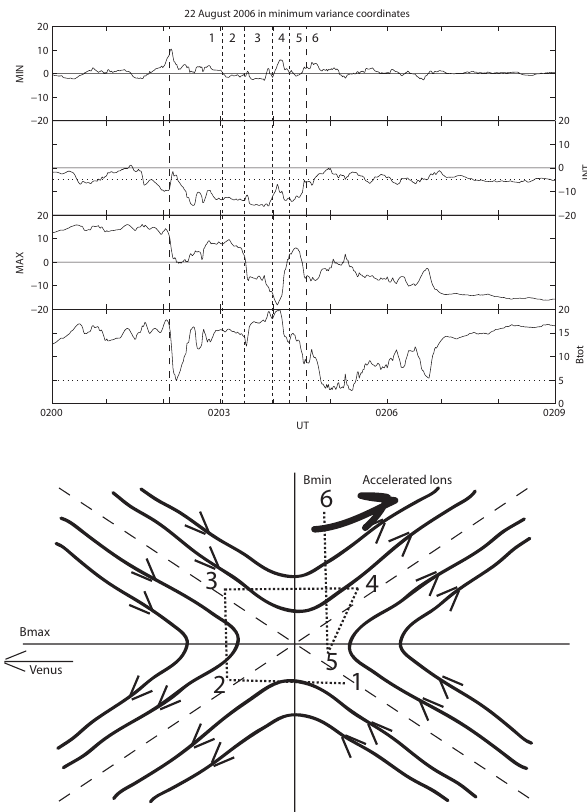
Fig. 1. Top panel: the magnetic field data in minimum variance coordinates. the vertical dashed lines show the interval of interest of this paper. Bottom panel: a sketch of the reconnection region with the path of VEX drawn in a dotted line and the highly accelerated ions drawn as a thick